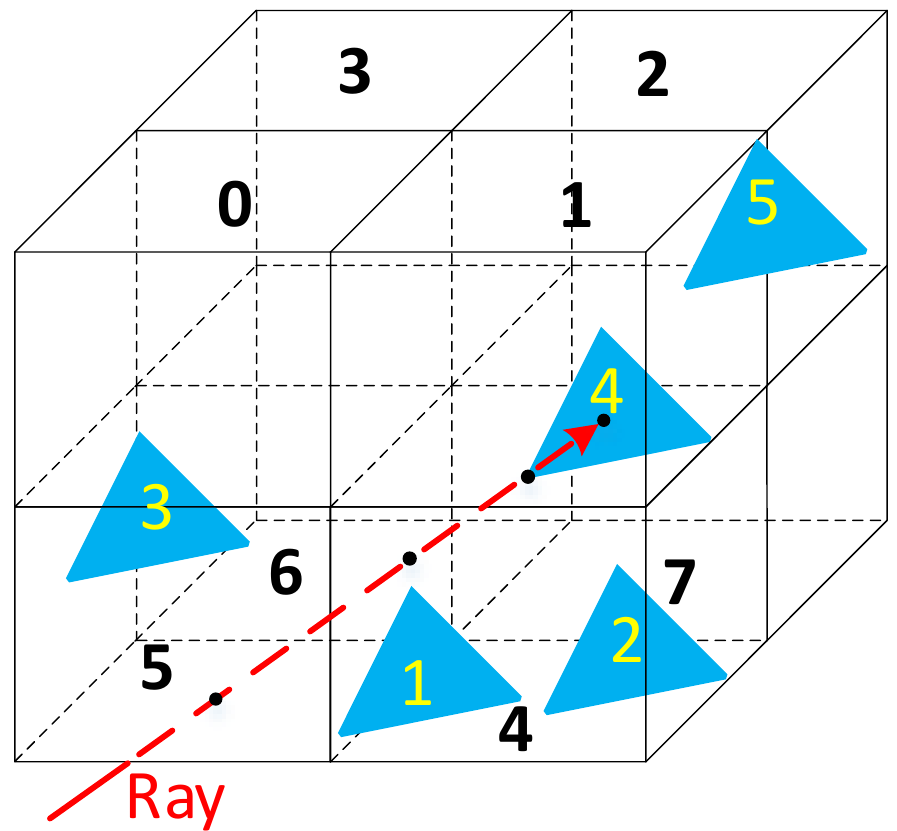
Figure 1. Ray tracing process in ray marching algorithm. The key aspect of the ray marching algorithm lies in the establishment of the cor- responding relation between leaf node and spatial unit, and its flowchart is shown in Figure